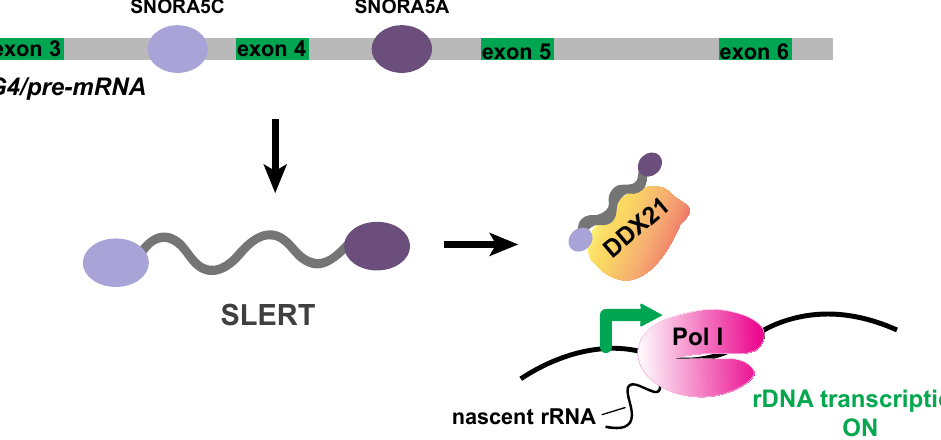
Figure 3. SLERT, a positive regulator of rDNA transcription. SLERT (snoRNA-ended lncRNA enhancing pre-ribosomal RNA transcription) is a snoRNA-ended lncRNA, derived from alternative splicing of TGFB4 pre-mRNA and contains two box H/ACA snoRNAs, the SNORA5C and SNORA5A sequences, at its 5 ′ and 3 ′ end, respectively. SLERT enters the nucleolus, binds to DDX21 to alter its conformation, permitting RNA pol I (Pol I) to transcribe the rDNA gene.